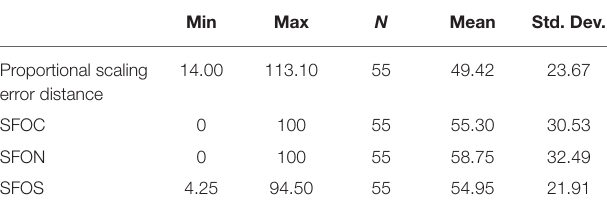
TABLE 1 | Descriptive Information for dependent